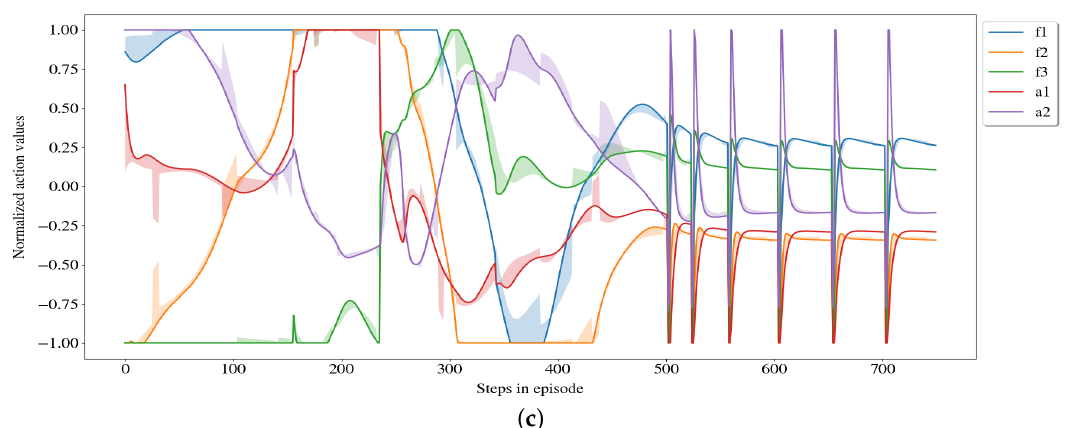
Figure 4. The visualization of the ( a ) feature attributions, ( b ) states, and ( c ) actions and from one episode for the developer. The shaded area in the action-plot shows the difference between the actions taken by the DRL-agent and predicted by the LMT.